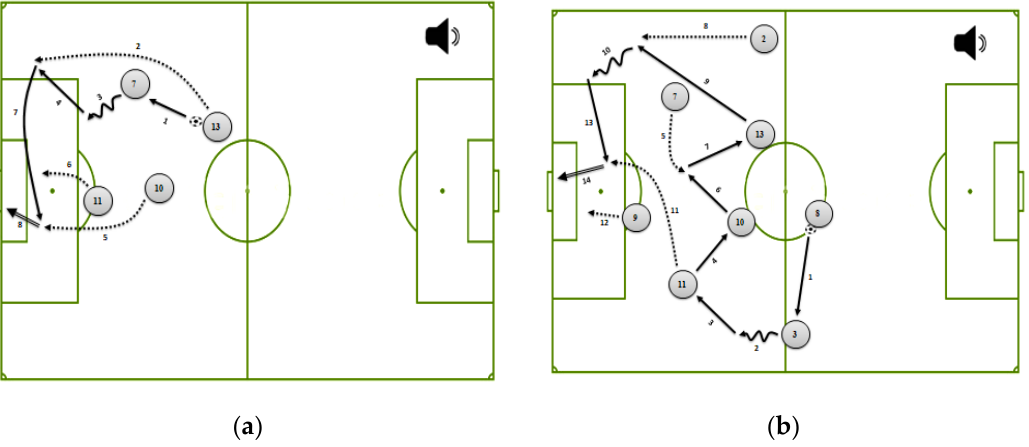
Figure 1. Simple ( a ) and complex ( b ) multimedia materials without cues.